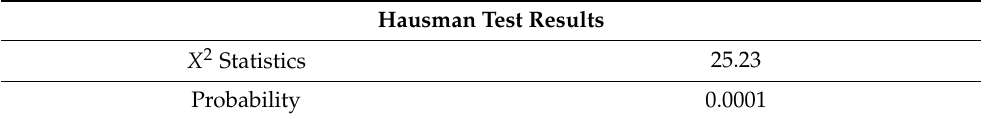
Table 6. Hausman test.